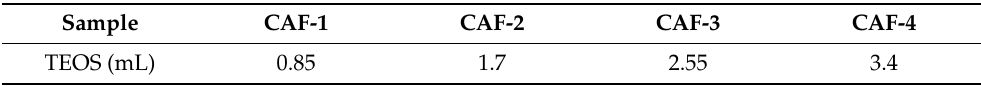
Table 2. CAFs formed by varying concentration of precursor TEOS.